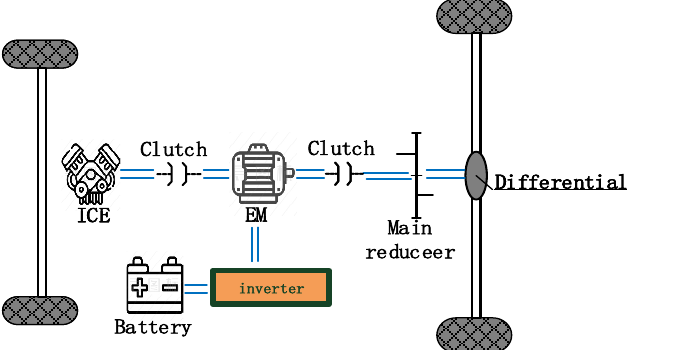
Figure 1. The PHEV powertrain framework. Table 1. Vehicle